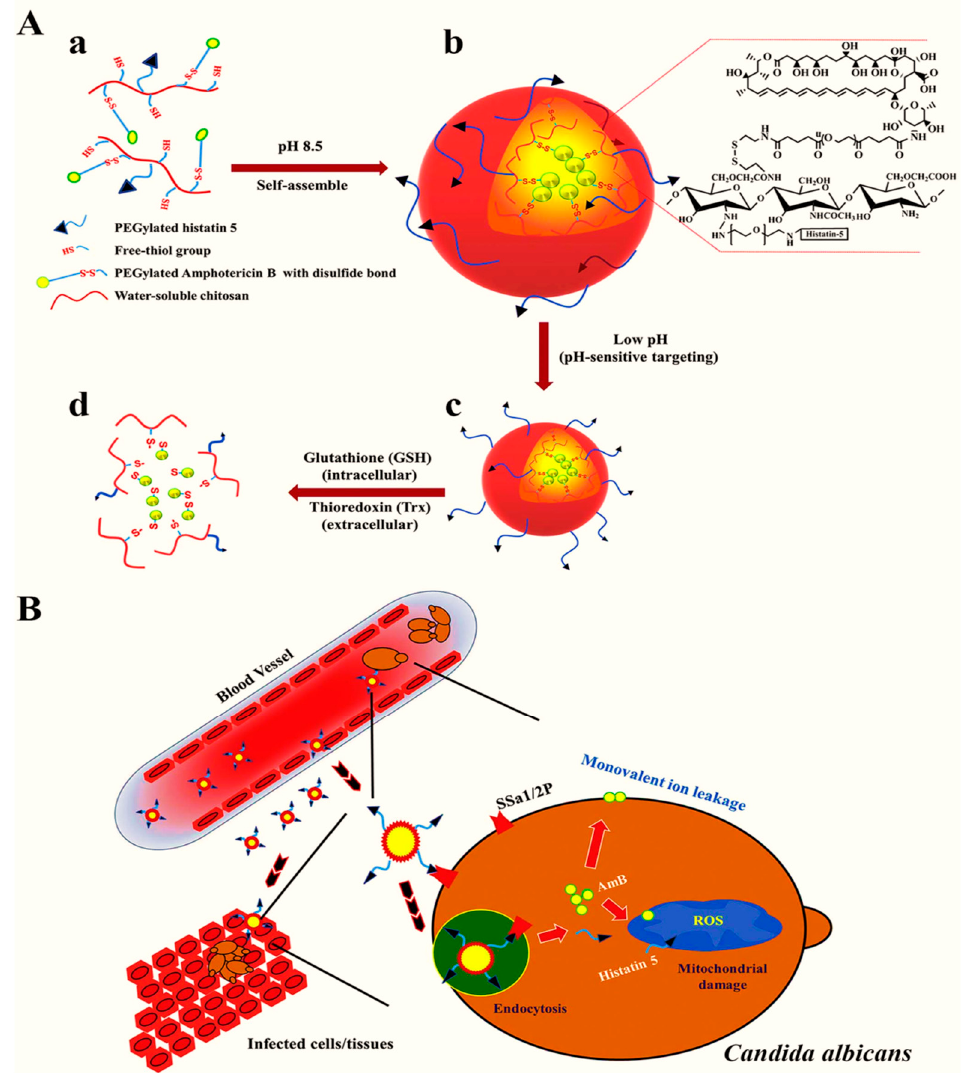
Figure 3. Conjugation of histatin 5 and amphotericin B with NPs. ( A ) conjugation of histatin 5 with chitosan and conjugation of a redox linker with amphotericin B (a), self-assembly of NPs through disulfide bonds between polymeric chains and formation of micelles through hydrophobic interaction of amphotericin B (b), pH-dependent activation of the targeting ligand, i.e., histatin 5 (c), release of amphotericin B through a reduction mechanism within the fungal cell (d). ( B ) Targeted uptake and intraendosomal release of amphotericin B and synergistic action of histatin B against fungal destruction. Reproduced from [147] , with permission from Elsevier, 2021.